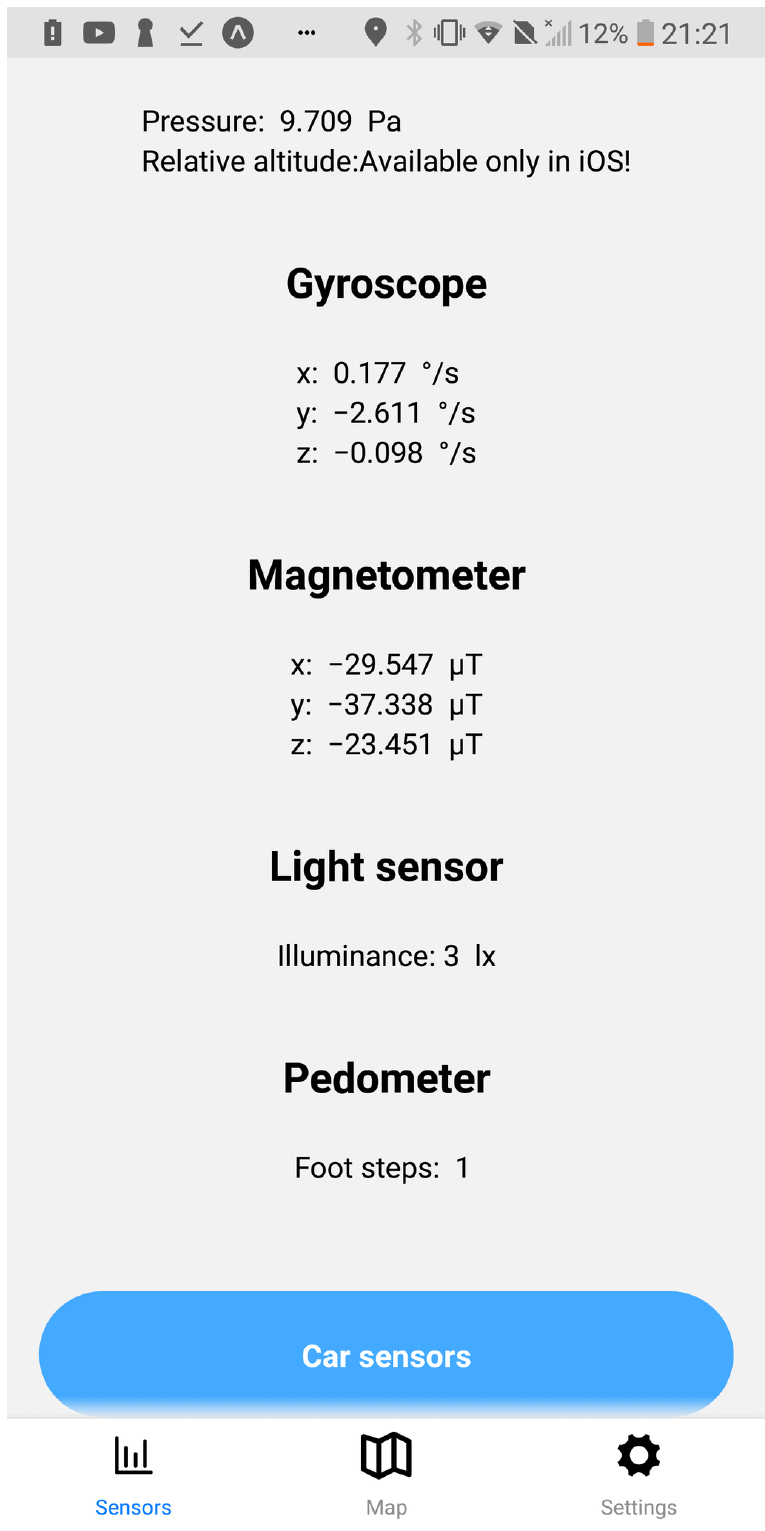
Figure 13. Smartphone’s sensor data representation in the mobile